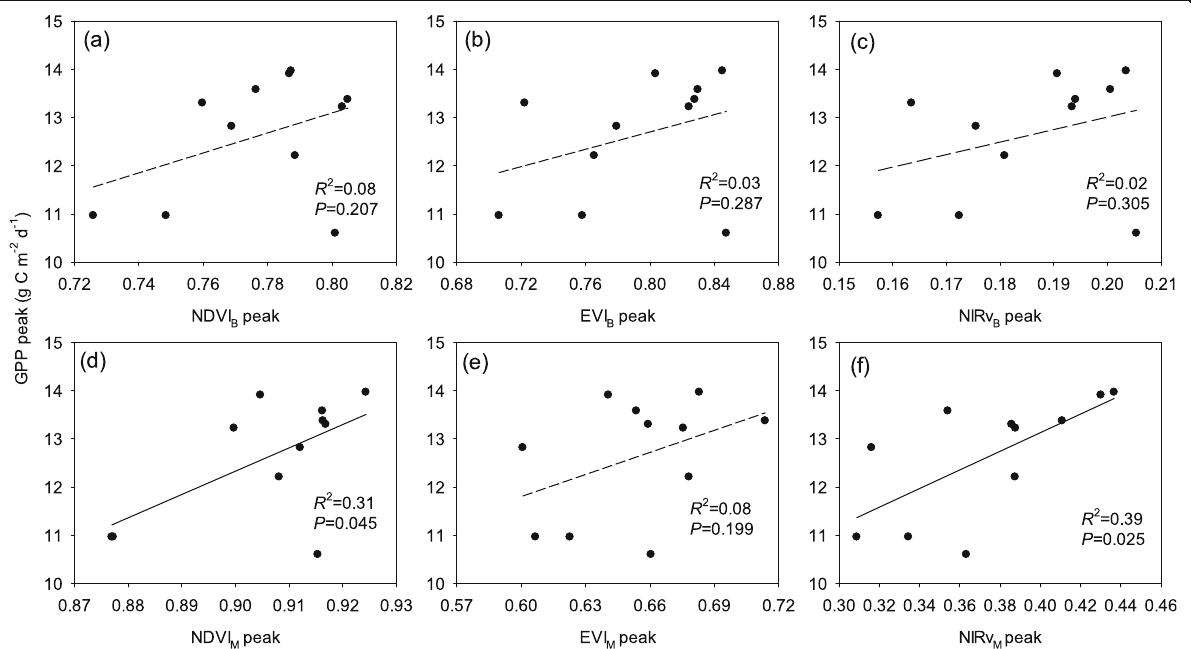
Fig. 7 Relationships between the summer peaks of gross primary production (GPP) and vegetation indices. NDVI B : broadband normalized difference vegetation index, EVI of